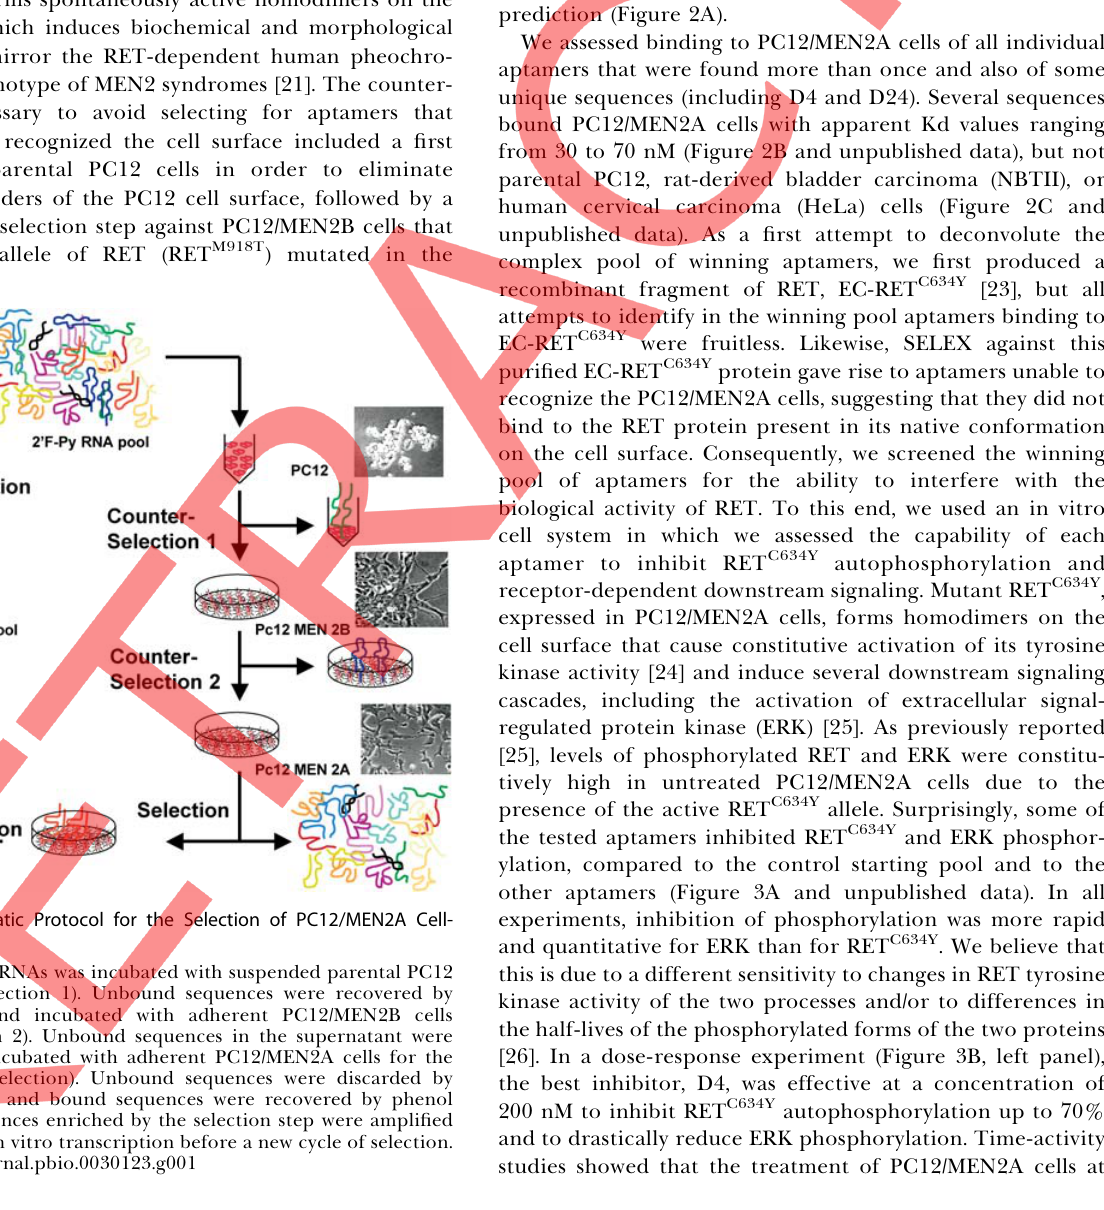
Figure 1. Schematic Protocol for the Selection of PC12/MEN2A Cell- Specific Aptamers A pool of 2 9 F-Py RNAs was incubated with suspended parental PC12 cells (Counterselection 1). Unbound sequences were recovered by centrifugation and incubated with adherent PC12/MEN2B cells (Counterselection 2). Unbound sequences in the supernatant were recovered and incubated with adherent PC12/MEN2A cells for the selection step (Selection). Unbound sequences were discarded by several washings, and bound sequences were recovered by phenol extraction. Sequences enriched by the selection step were amplified by RT-PCR and in vitro transcription before a new cycle of selection. DOI: 10.1371/journal.pbio.0030123.g001 PLoS Biology |